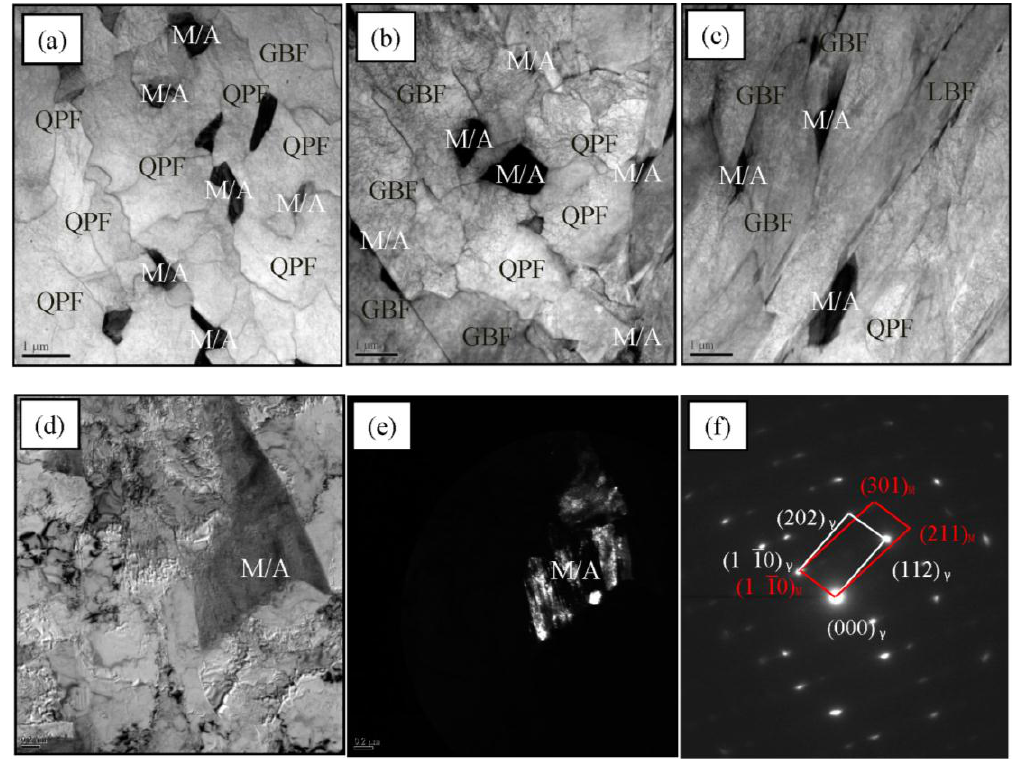
Figure 5. Typical TEM observations of GBF, AF and LBF plates with M/A constituent in samples of: ( a ) 5 °C/s; ( b ) 15 °C/s ;and ( c ) 20 °C/s; and a typical M/A constituent indicated by: ( d ) bright field; ( e ) dark field; and ( f ) selected area diffraction pattern. QPF—quasi-polygonal ferrite, GBF—granular bainitic ferrite, LBF—Lath bainitic ferrite and M/A—martensite/austenite.